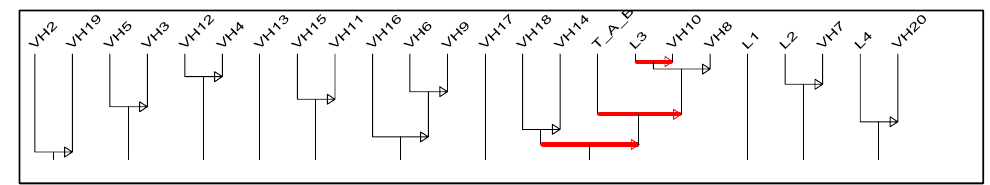
Figure 8. Implicative tree for variables Type L (level of geometrical thinking of the students), T_A_B (the student solves the whole tasks A and B correctly) and VH (student´s solution to the van Hiele test).